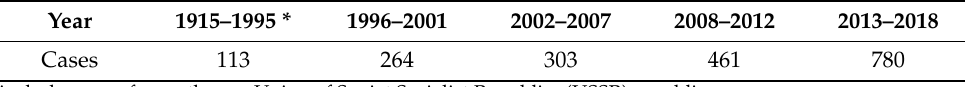
Table 1. Dynamics of D. repens infections in humans in the territory of Russia (1915–2018).